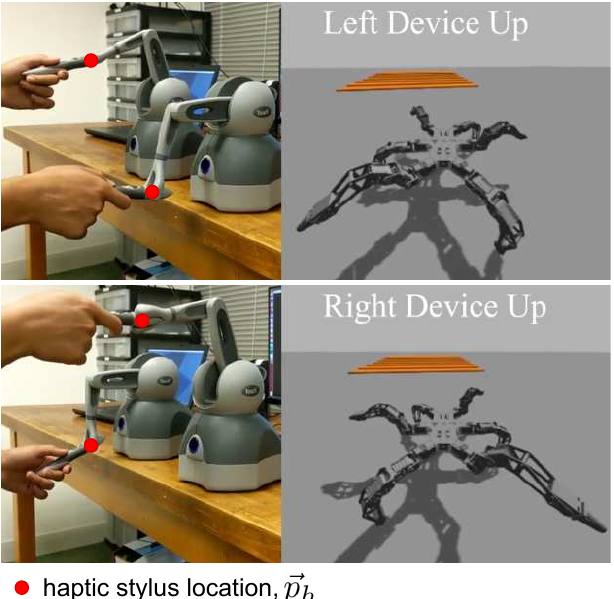
Figure 5. Haptic device to alternating tripod group mapping for forward or backward motion using the haptic operator interface. The red dot indicates the stylus